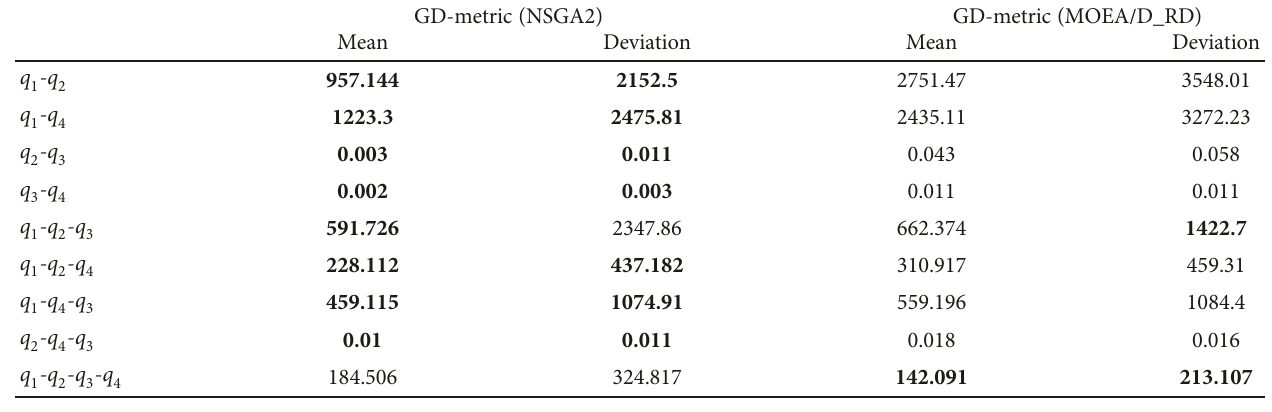
Table 6: Comparison of GD-metric of MOEA/D_RD and NSGA2.